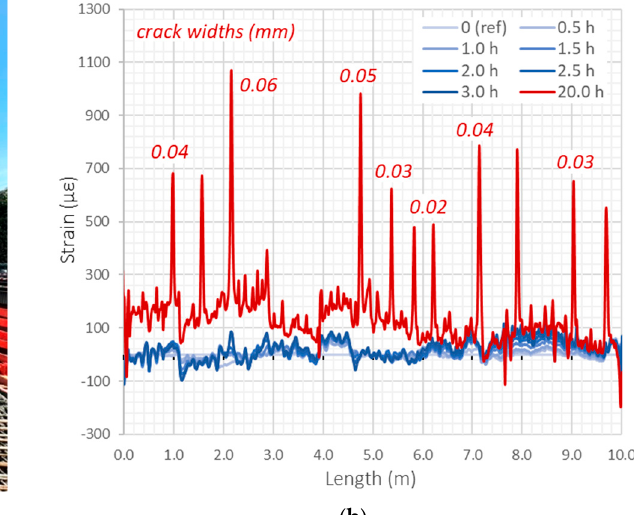
Figure 17. Installation of the monolithic sensor by tying to the existing reinforcement.